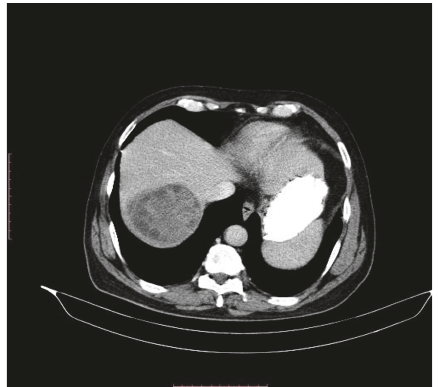
Figure 1: Hydatid cyst in right lobe liver on CT scan.